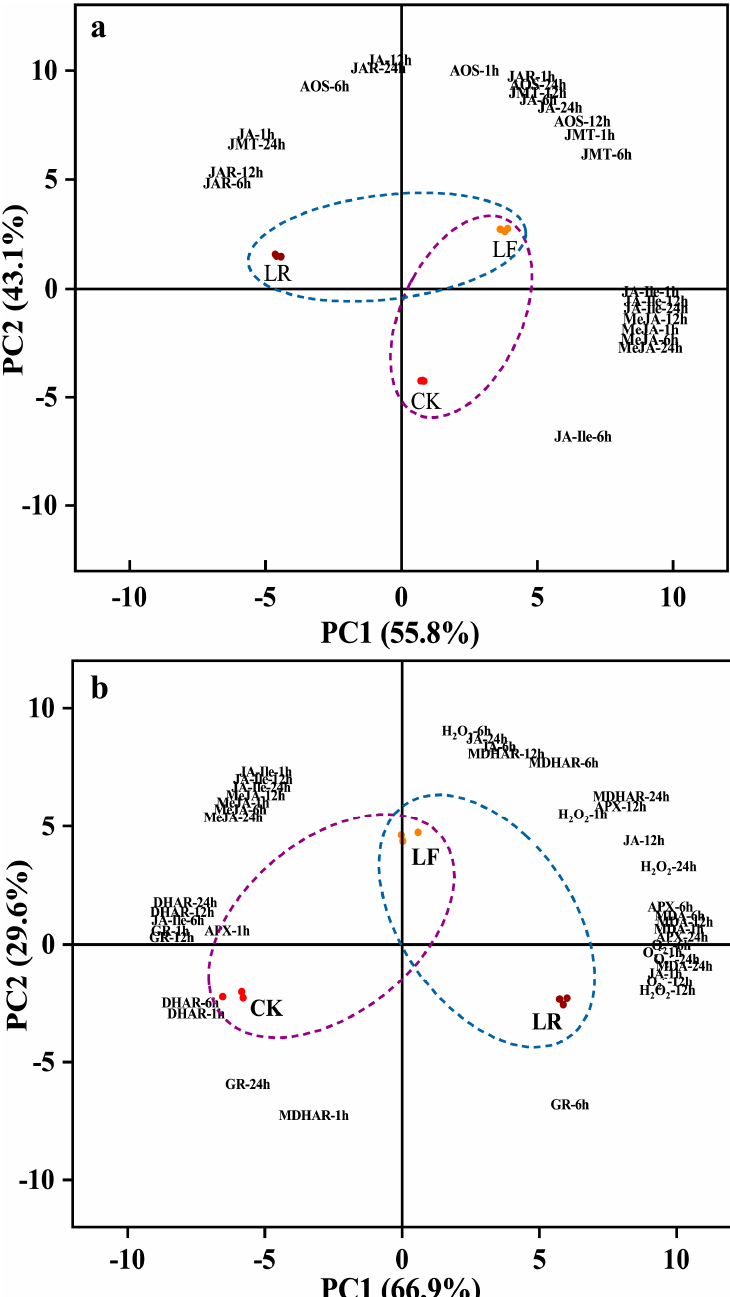
Figure 6. Plots showing the PCA of jasmonate levels, key enzymes of the jasmonate biosynthesis pathway ( a ), key enzymes of the ascorbate–glutathione cycle, and ROS levels ( b ) in the roots of plants with leaves (LF) and plants without leaves (LR) under suboptimal low root–zone temperatures.